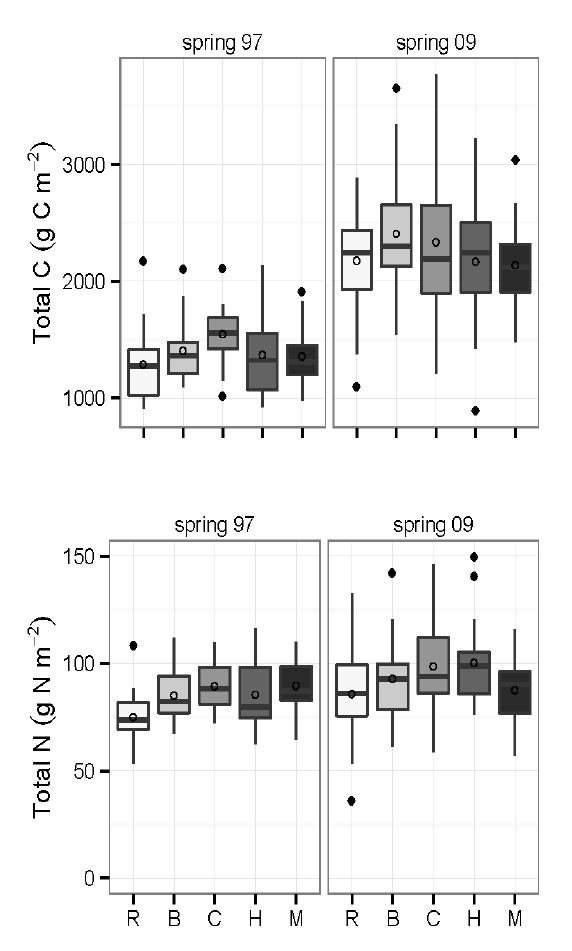
Figure 2. Box plots of C and N pools (0–30 cm mineral soil layer) for longleaf pine forests at Eglin Air Force Base, Florida, USA. The boundary of the box plot closest to zero indicates the 25th percentile, the line within the box marks the median, the open circle indicates the mean, and the boundary of the box plot farthest from zero indicates the 75th percentile. Error bars above and below indicate the 90th and 10th percentile. Means (open circles) for treatments (Reference not included in the GLMM analysis) with the same letter do not differ at p < 0.05. R = reference; B = burn-only; C = delayed burn; H = herbicide; M =